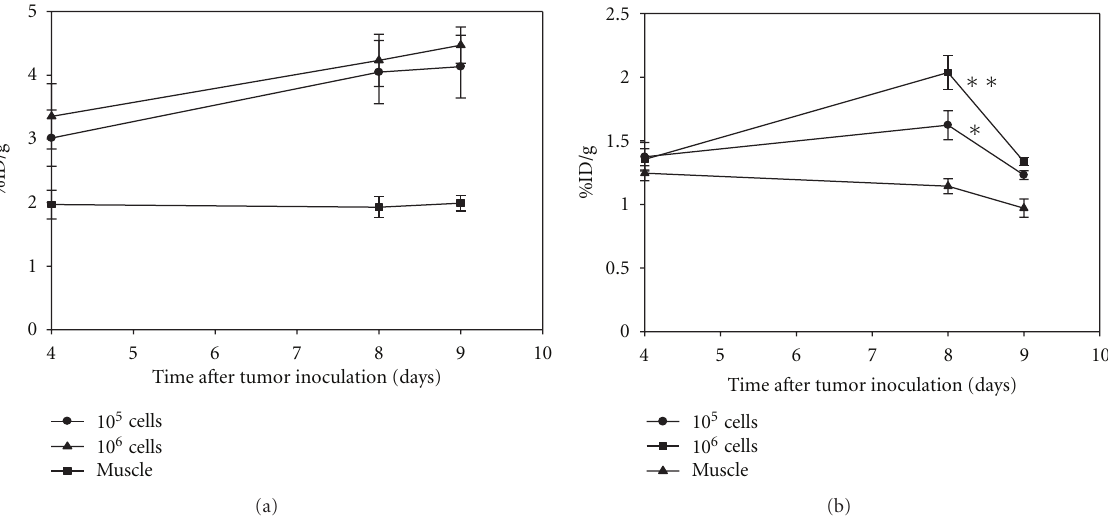
Figure 2: Longitudinal quantification of the progression of tumor growth in various sizes in C26-bearing mice derived from 18 F-FDG (a) or 18 F-FLT (b) microPET images. The uptakes of SUV in 18 F-FLT were significantly decreased after lipo-Dox treatment. (mean ± SD, n = 3; ∗ P < 0.05; ∗∗ P <